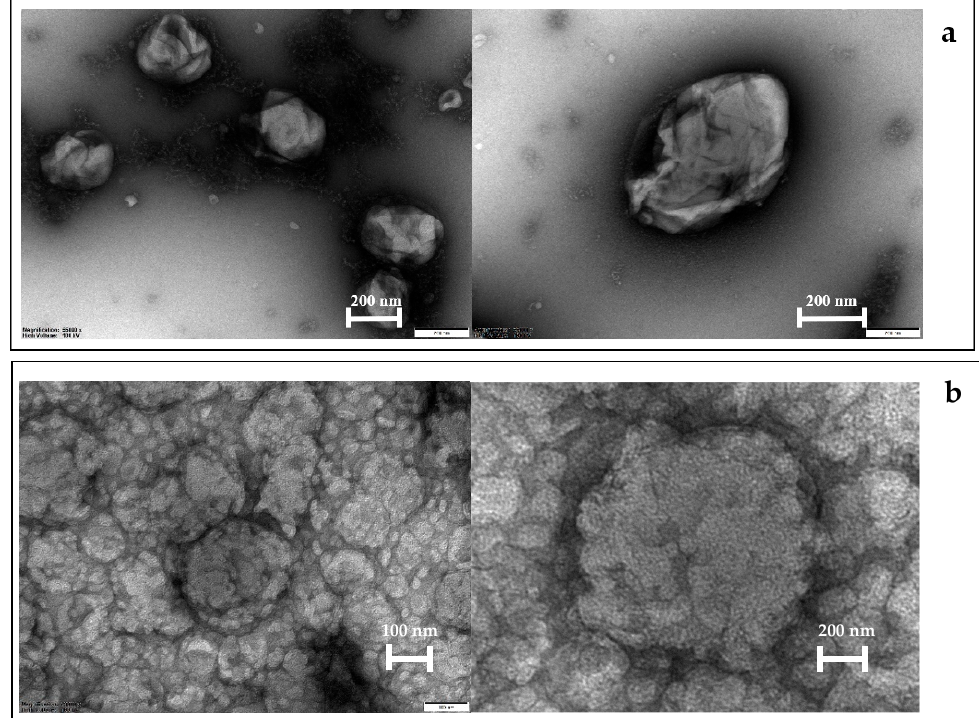
Figure 4. TEM of ( a ) blank ethosomes and ( b ) extract-loaded ethosomes.